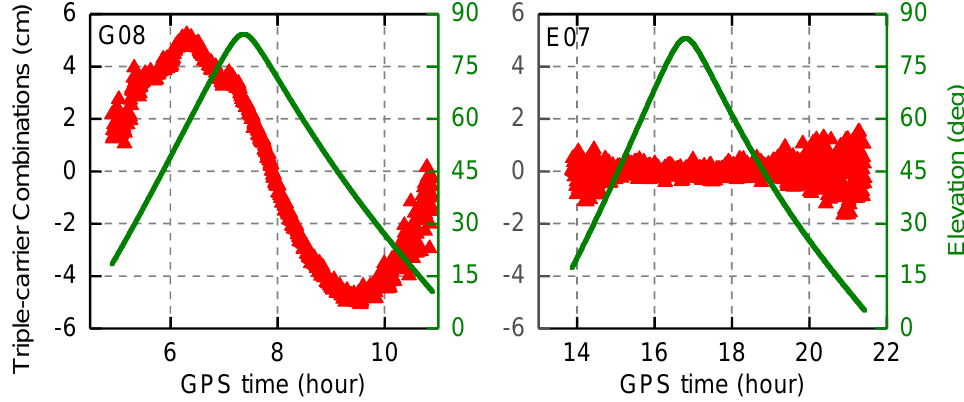
Figure 8. Variations of triple-frequency carrier phase combinations and elevation for G08 and E07 satellites at station WUH1 on 28 May 2018.